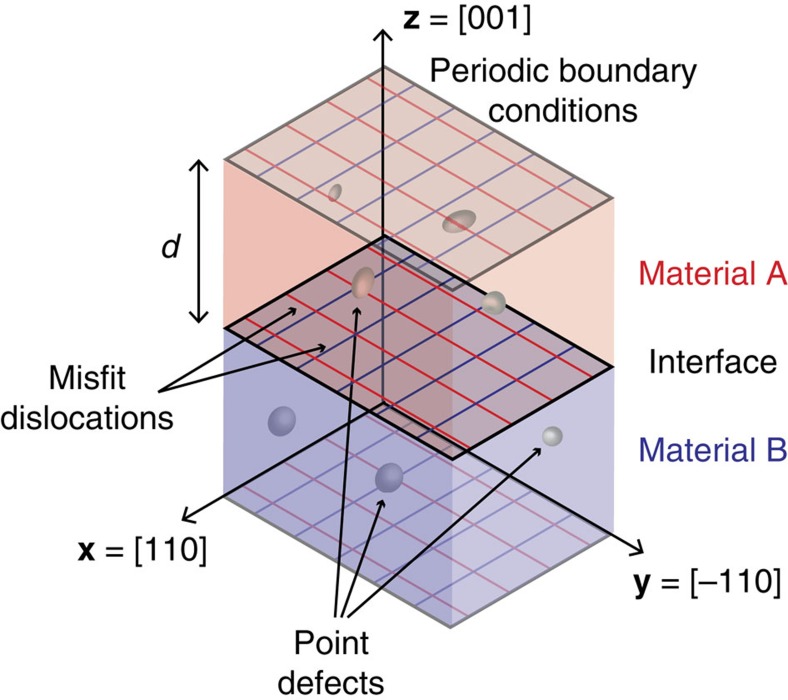
Schematic illustration of our model.We simulate the diffusion of radiation-induced point defects (illustrated by ovals) to interfaces under the influence of interface elastic fields. In general, materials A and B may be any two crystalline solids. In the present work, they are chosen to be either Cu or Ag (see Table 1 for details).